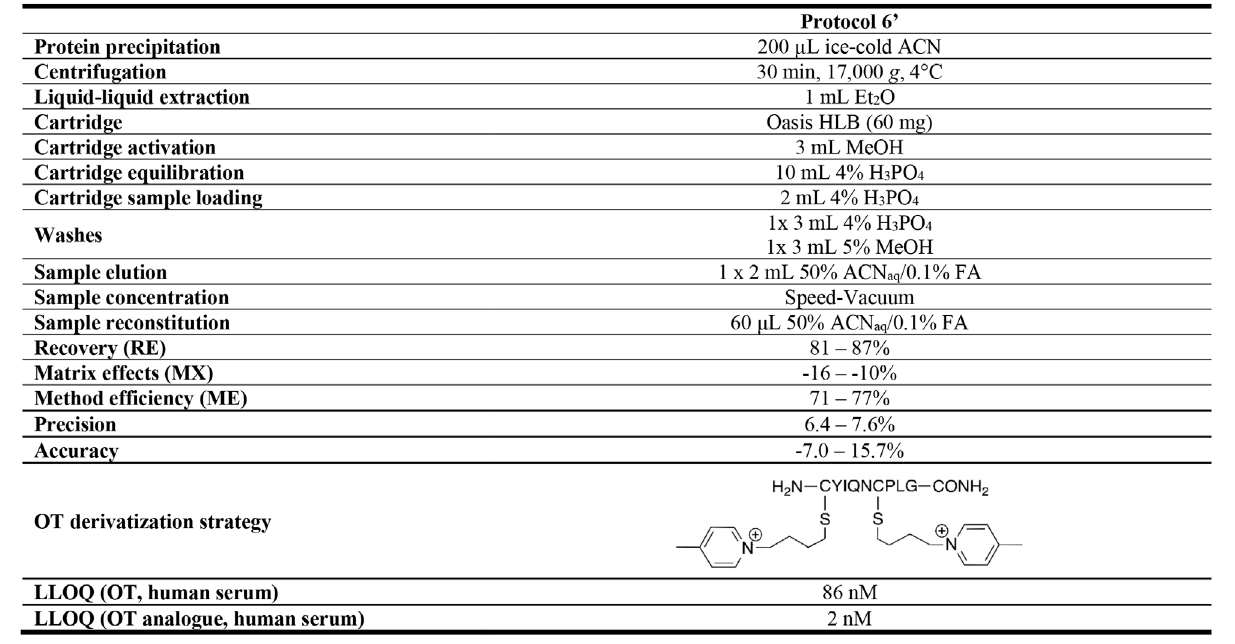
TABLE3| OptimizedsamplepreparationProtocol6 ’ .RE,MX,andMEforoptimizedProtocol6 ’ wereevaluatedinhumanserum via thepre-andpost-spikemethod(50 μ M, 10 µM, 0.1 µM). Precision and accuracy were determined by spiking samples with 40, 10 and 1.5 µM OT. The OT analogue derivatized with 1-(4-bromobutyl)-4- methylpyridin-1-ium had the lowest LLOQ when evaluated in human serum.